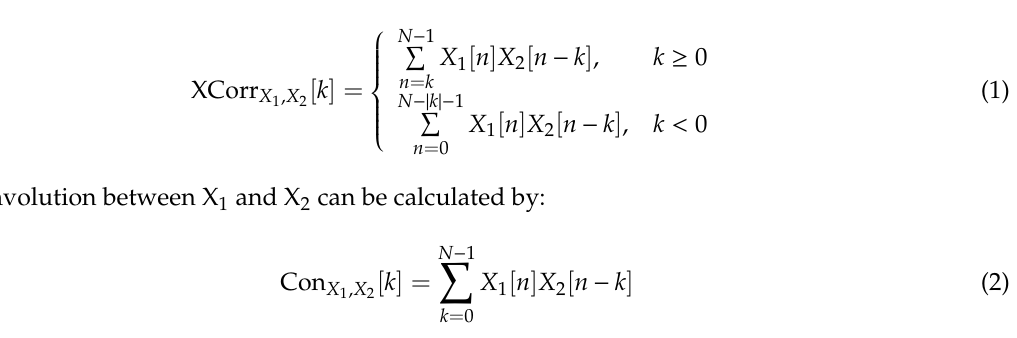
Figure 2. General flow of the proposed generic model multiple-objective genetic algorithm (MOGA) optimized deep multiple kernel learning support vector machine (D-MKL-SVM). Cross-correlation between two ECG signals X 1 and X 2 with length of N = 100 (zero-padding when len{X}<100) is given in Equation (1).